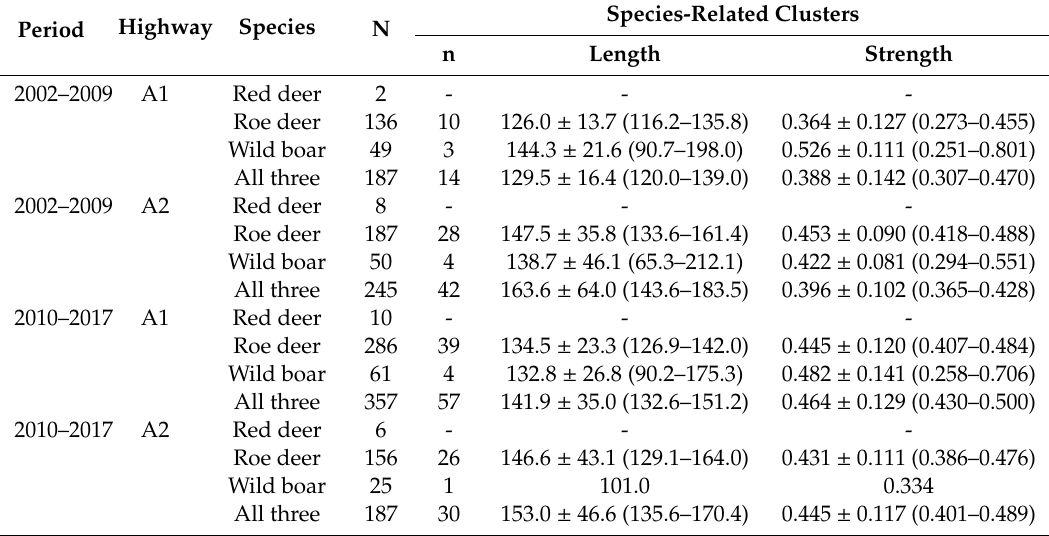
Table 5. Basic characteristics of ungulate-vehicle collision clusters on highways A1 and A2 in 2002–2009 and 2010–2017. N—number of species-related accidents, n—number of accident clusters, length and strength presented as average ± SD, 95% confidence interval given in